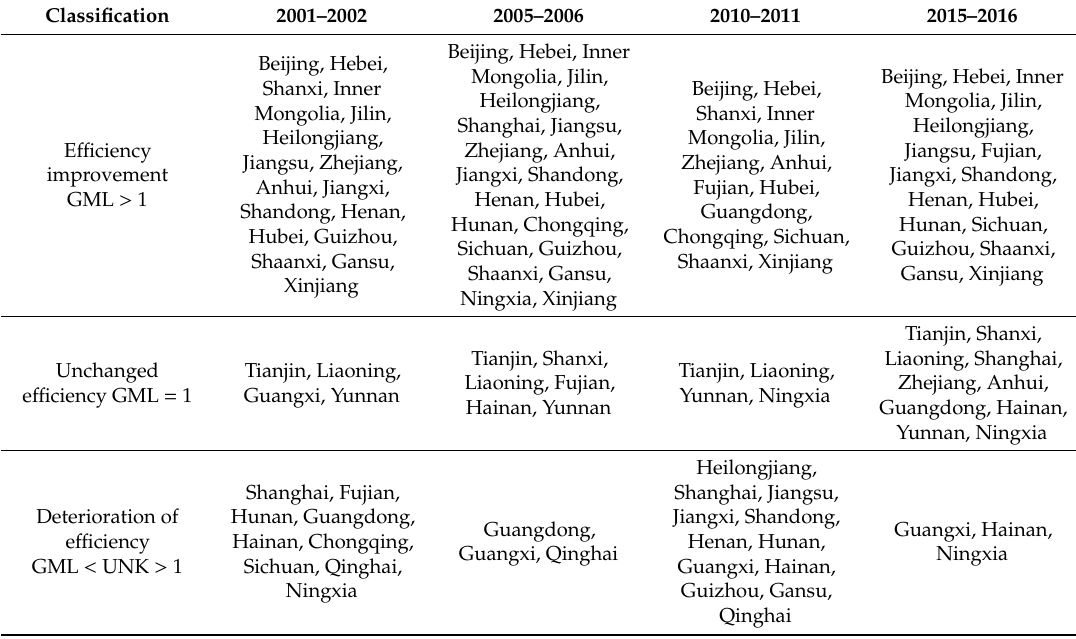
Table 3. Variations in water resources green e ffi ciency index values in provinces during selected years of the study period